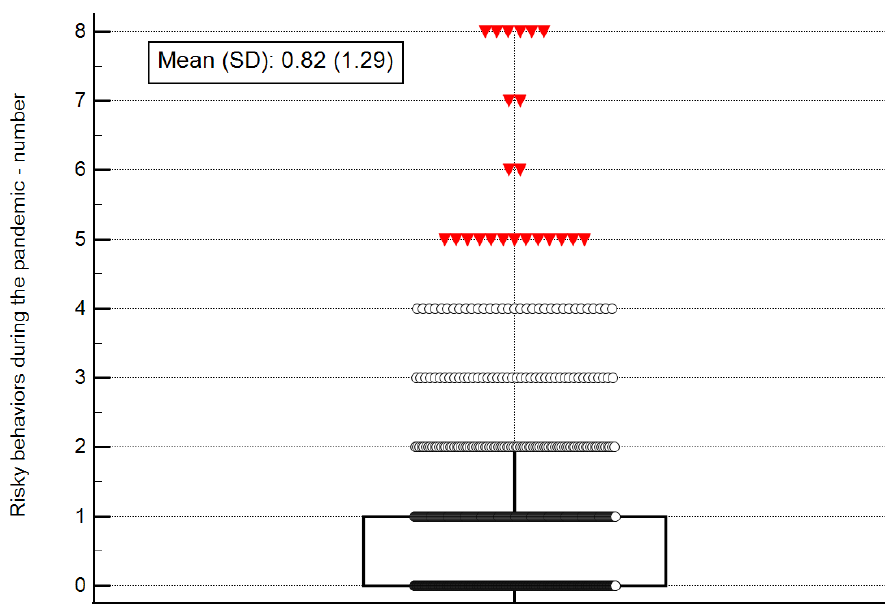
Figure 1. Number of risky behaviors during the pandemic. Note: SD, standard deviation. The central box represents the values from the lower to upper quartile (25 to 75 percentile); the vertical line extends from the minimum to the maximum value, excluding outside values, displayed as separate points. An outside value is defined as a value that is smaller than the lower quartile minus 1.5 times the interquartile range, or larger than the upper quartile plus 1.5 times the interquartile range. Table 4. Changes in risky behavior during the pandemic among